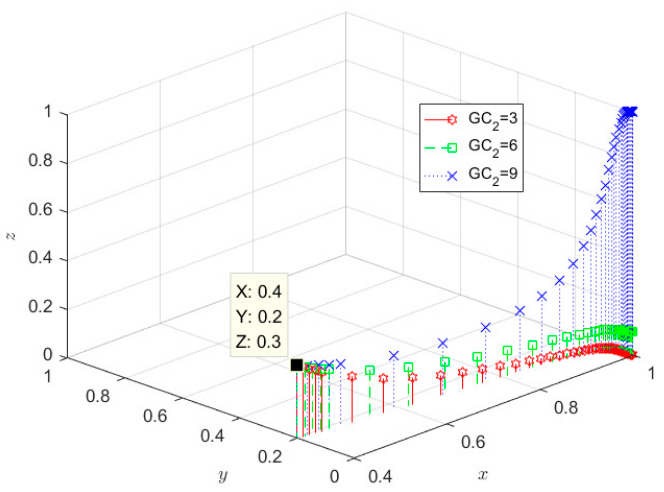
Figure 6. Impact of government subsidies for participating in the recycling of wastewater. The evolutionary results are set at GC 3 to 0.6, 1.2, and 1.8, respectively, shown in Figure 7. It can be seen from Figure 7 that the rate of government evolving into a positive supervision strategy slows down as the government cost without any incentive increases, which indicates that with the increase of supervision cost, the government’s willingness to choose negative supervision increases, and the rate of SRW producers and SRW recyclers evolving into non-ecological behaviour and unqualified treatment gradually accelerates.